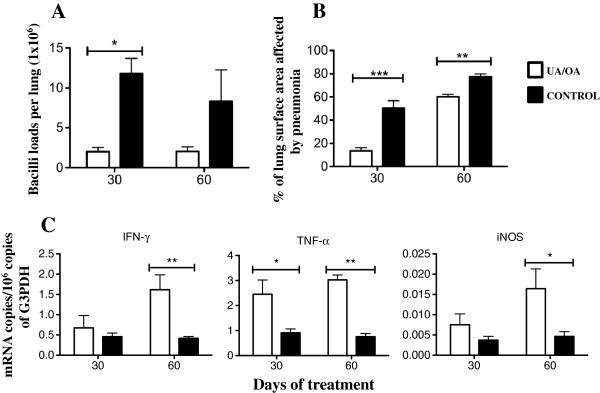
Effect of Ursolic acid (UA)/Oleanolic acid (OA) treatment on lung bacillary loads, pathology and cytokine expression during late disease produced by the multidrug-resistant (MDR) clinical isolate. (A) UA/OA mixture was administered 3 times per week (white bars) for 2 months, starting at day 60 post-infection with the MDR clinical isolate (CIBIN/UMF 15:99), decreased bacterial loads when compared with non-treated control animals (black bars). (B) These UA/OA-treated mice displayed a lesser pneumonia area than the control animals. (C) Administration of both terpenoids induced higher expression of proinflammatory cytokines and inducible iNOS. Each point corresponds to the mean ± Standard deviation (SD) of groups of four mice. Asterisks represent statistical significance between groups (*P <0 · 05; **P <0 · 01).